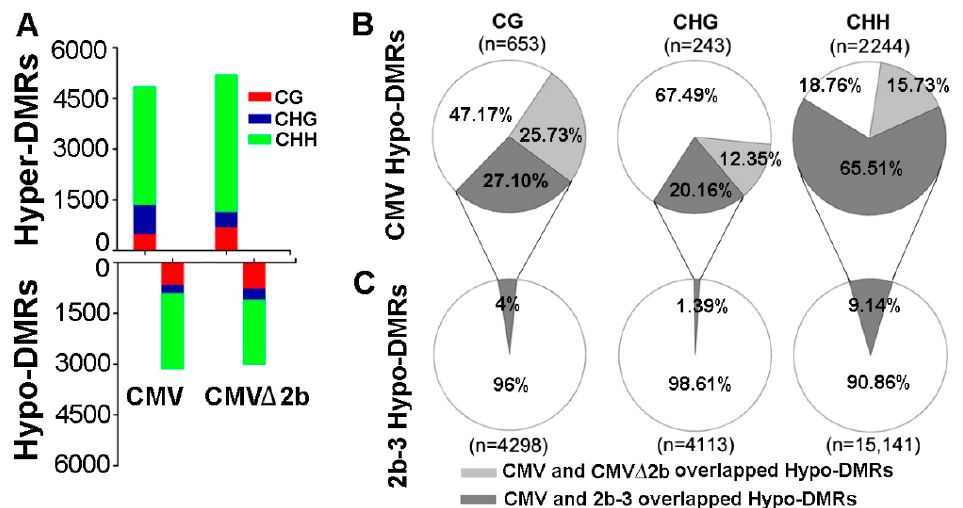
Figure 1. Comparison of the DMRs identified in CMV-, CMV ∆ 2b- and 2b-3 plants compared to Col-0 plants. ( A ) Comparison of the methylation levels of Hyper- and Hypo-DMRs in CG, CHG and CHH contexts in CMV-, CMV ∆ 2b- plants compared to Col-0 plants. ( B ) The Hypo-DMRs identified in CMV-plants overlap with those identified in CMV ∆ 2b- and 2b-3 plants. ( C ) The overlap of Hypo-DMR identified in 2b-3 plants with that identified in CMV-plants. The numbers of Hypo-DMRs loci in each context are shown ( n